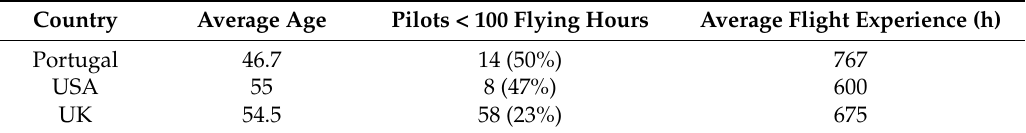
Table 2. Pilot average age and flying hours.